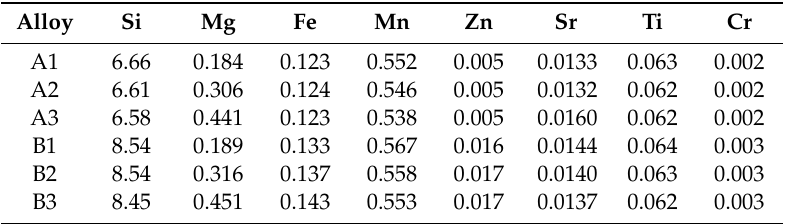
Table 2. Composition of the produced